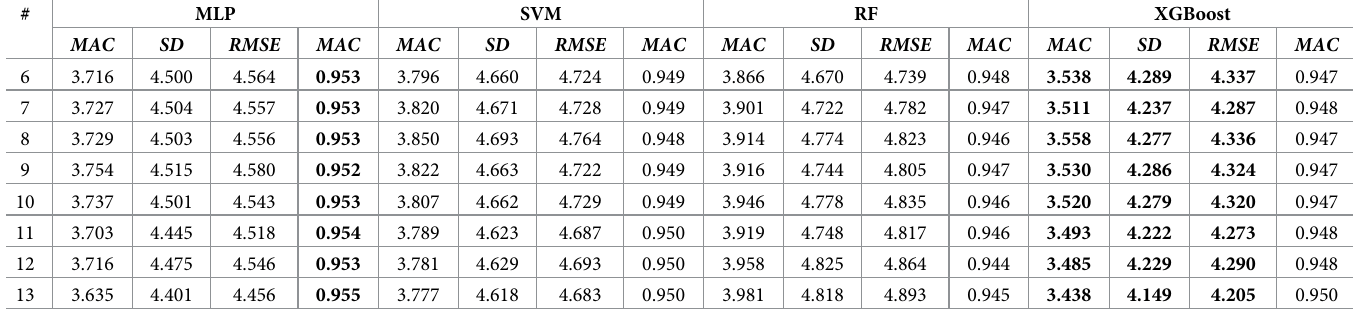
Table 6. Experimental results for the MLP, SVM, RF, and XGBoost, based on the StatLib dataset, with PCA feature extraction (best results are highlighted in bold; # means the number of